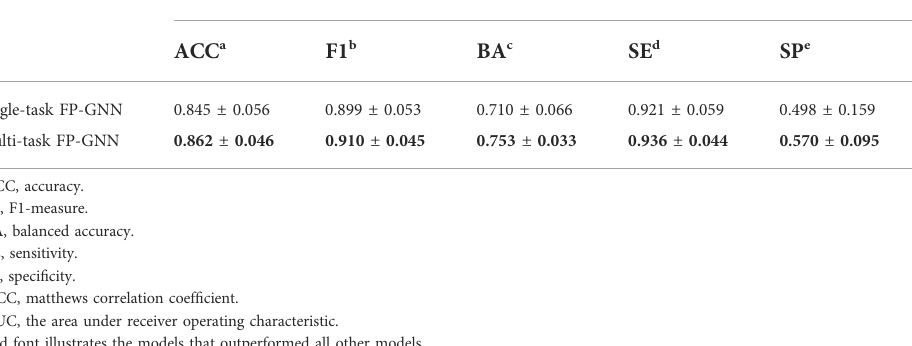
that the multi-task FP-GNN algorithm shows superiority in predicting the biological activity of molecules. Y-scrambling test was performed to prove that the results of the multi-task FP-GNN model were not due to a chance connection.